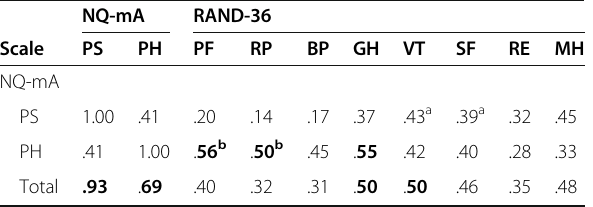
Table 6 Inter-scale correlations between Nuss Questionnaire modified for Adults and RAND-36